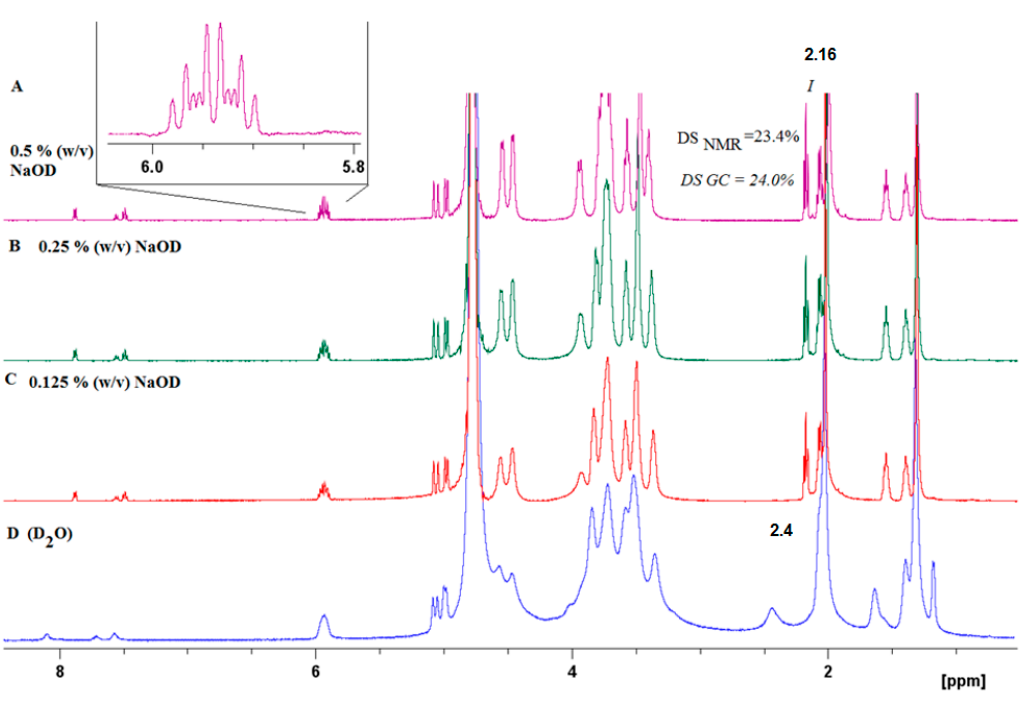
Figure 2. 1 H NMR of HA-UDA (Mw = 261,800 g/mol) acquired in D 2 O without (d), and (a-c) increasing the concentration of NaOD (up to 0.5 % (w/v)).